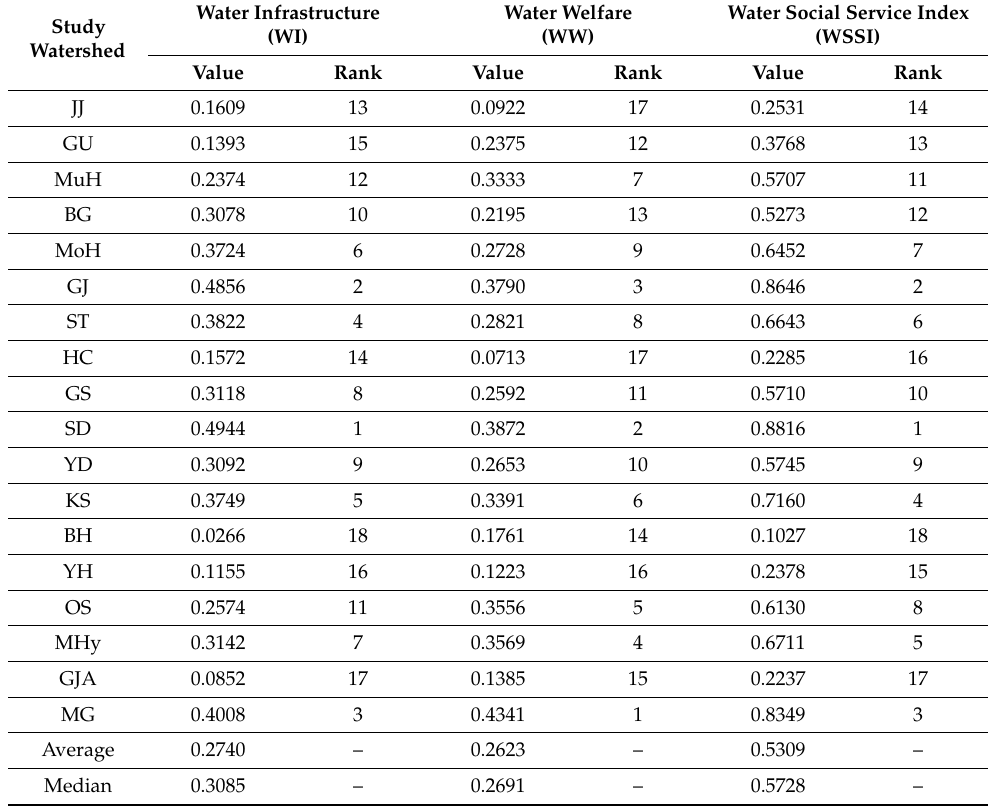
Table 10. Mean water social service index during the study